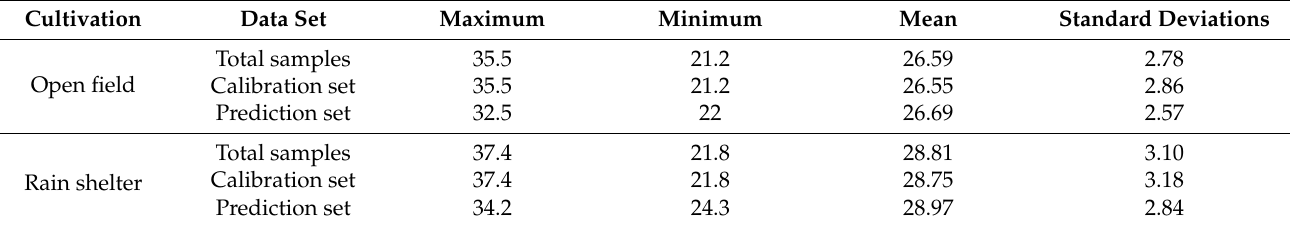
Table 1. Statistics of soluble solids content (%).